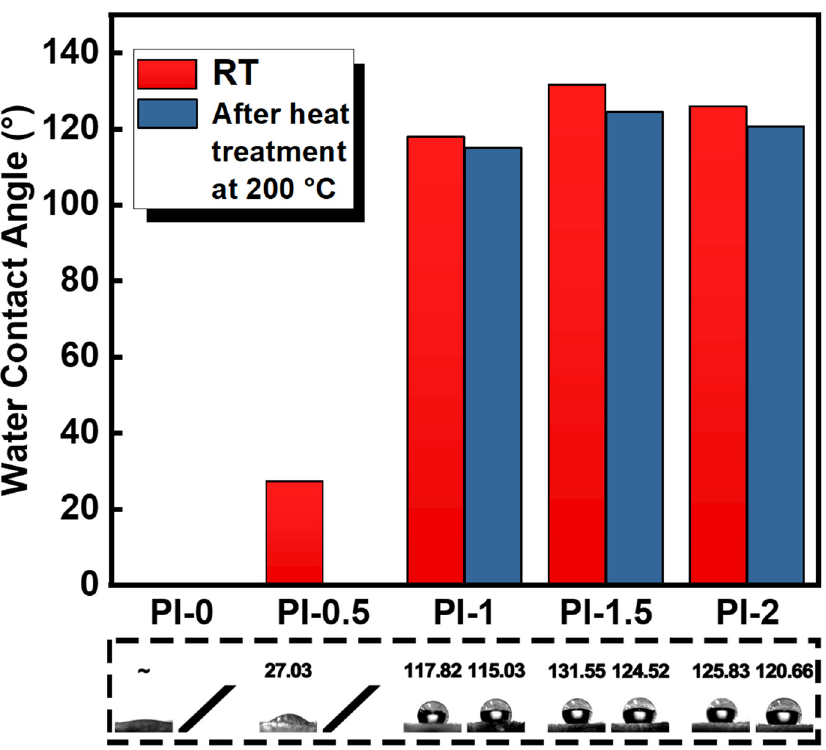
Figure 8. Contact angle data of PI-0, PI-0.5, PI-1, PI-1.5, and PI-2.